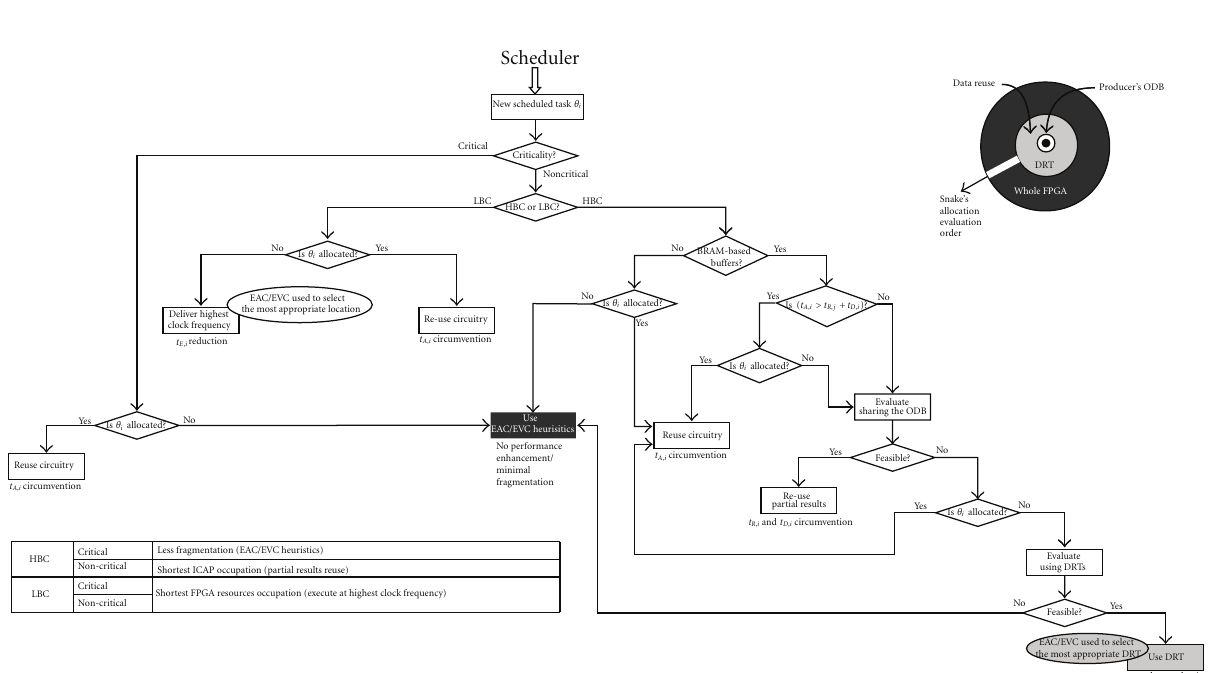
Figure 9: Different implementation versions for the hardware tasks.